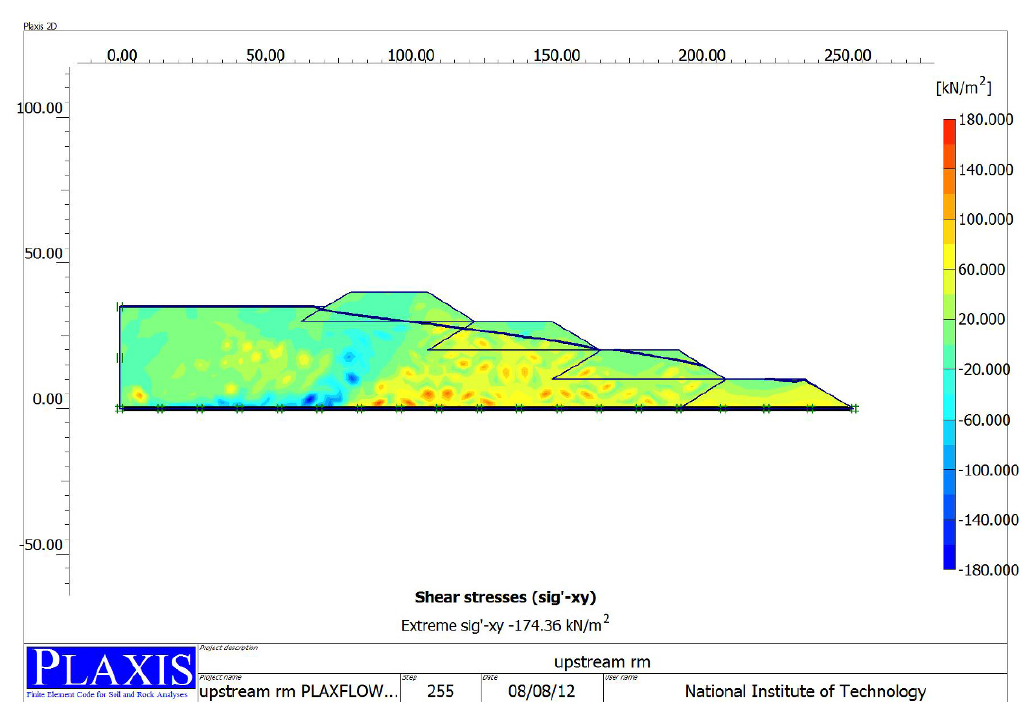
Figure 11. Effective stress diagram of upstream method dam in ZZ